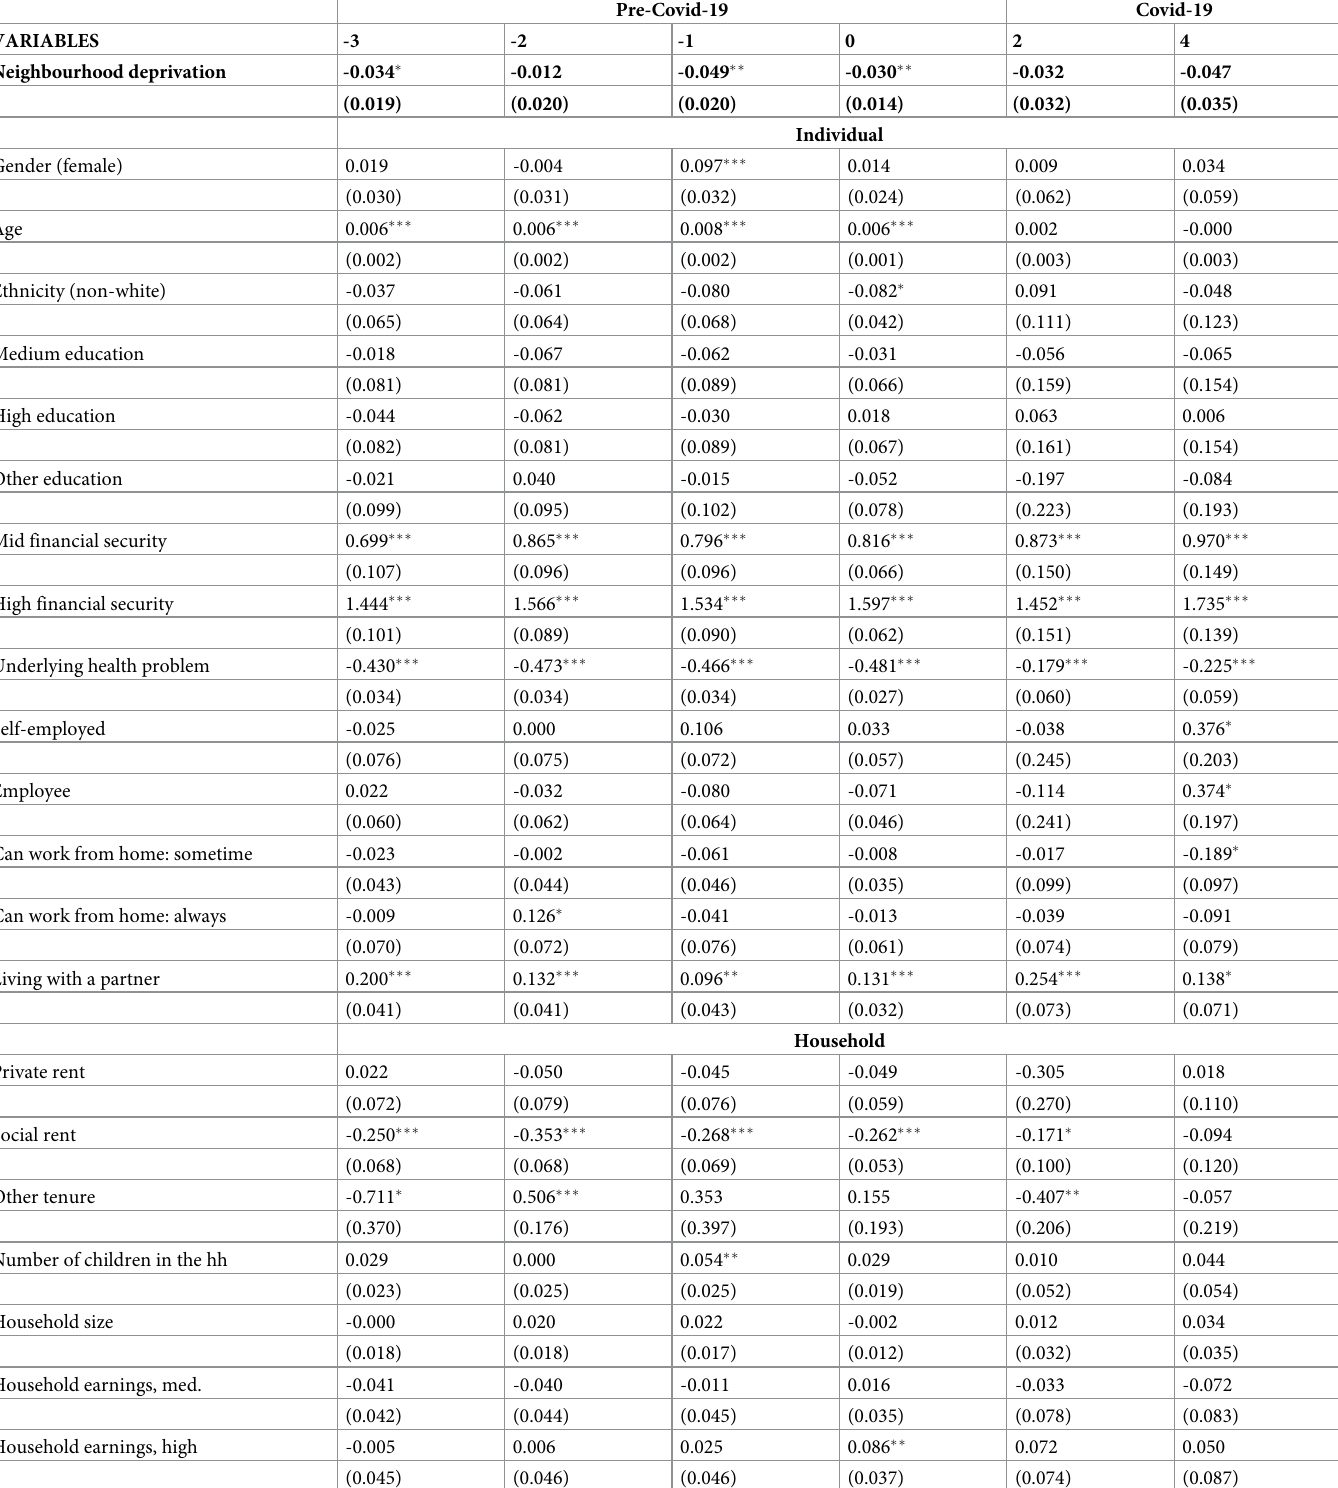
Table 3. Evaluative Well-being, full model OLS cross-section by